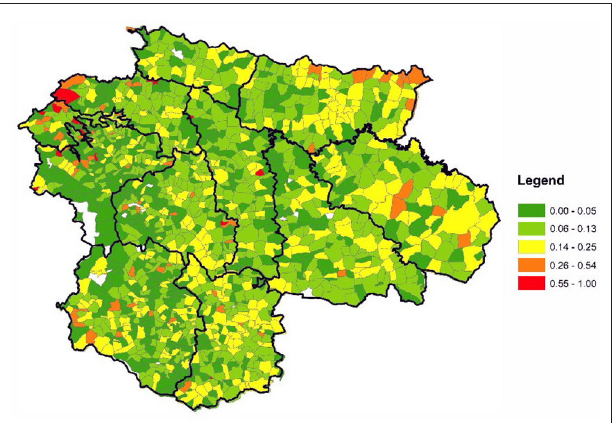
FIGURE 14 | Proportion of the population who are Scheduled Castes and Scheduled Tribes.